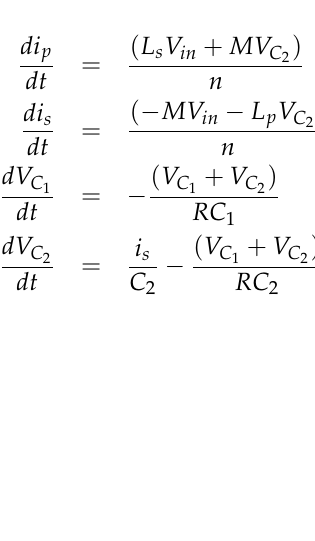
Figure 2. Typical behavior of the currents flowing by the coils in the steady state of a Period-1